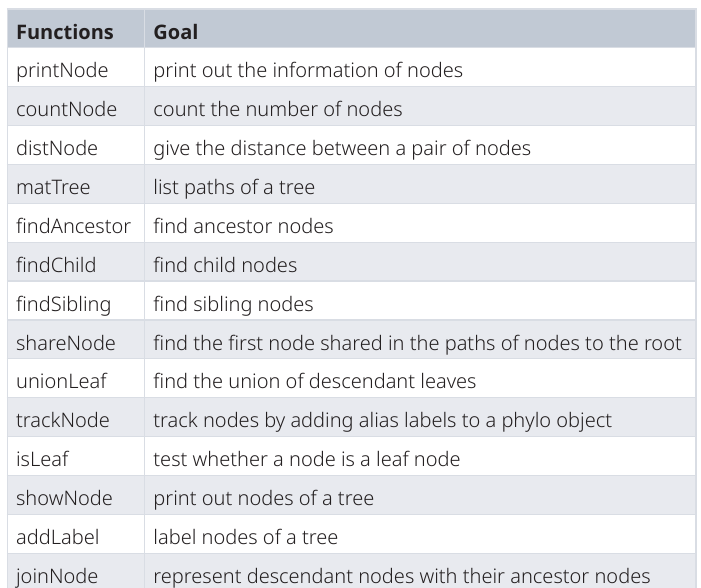
Table 1. A table lists some functions operating on the phylo object that are available in the TreeSummarizedExperiment